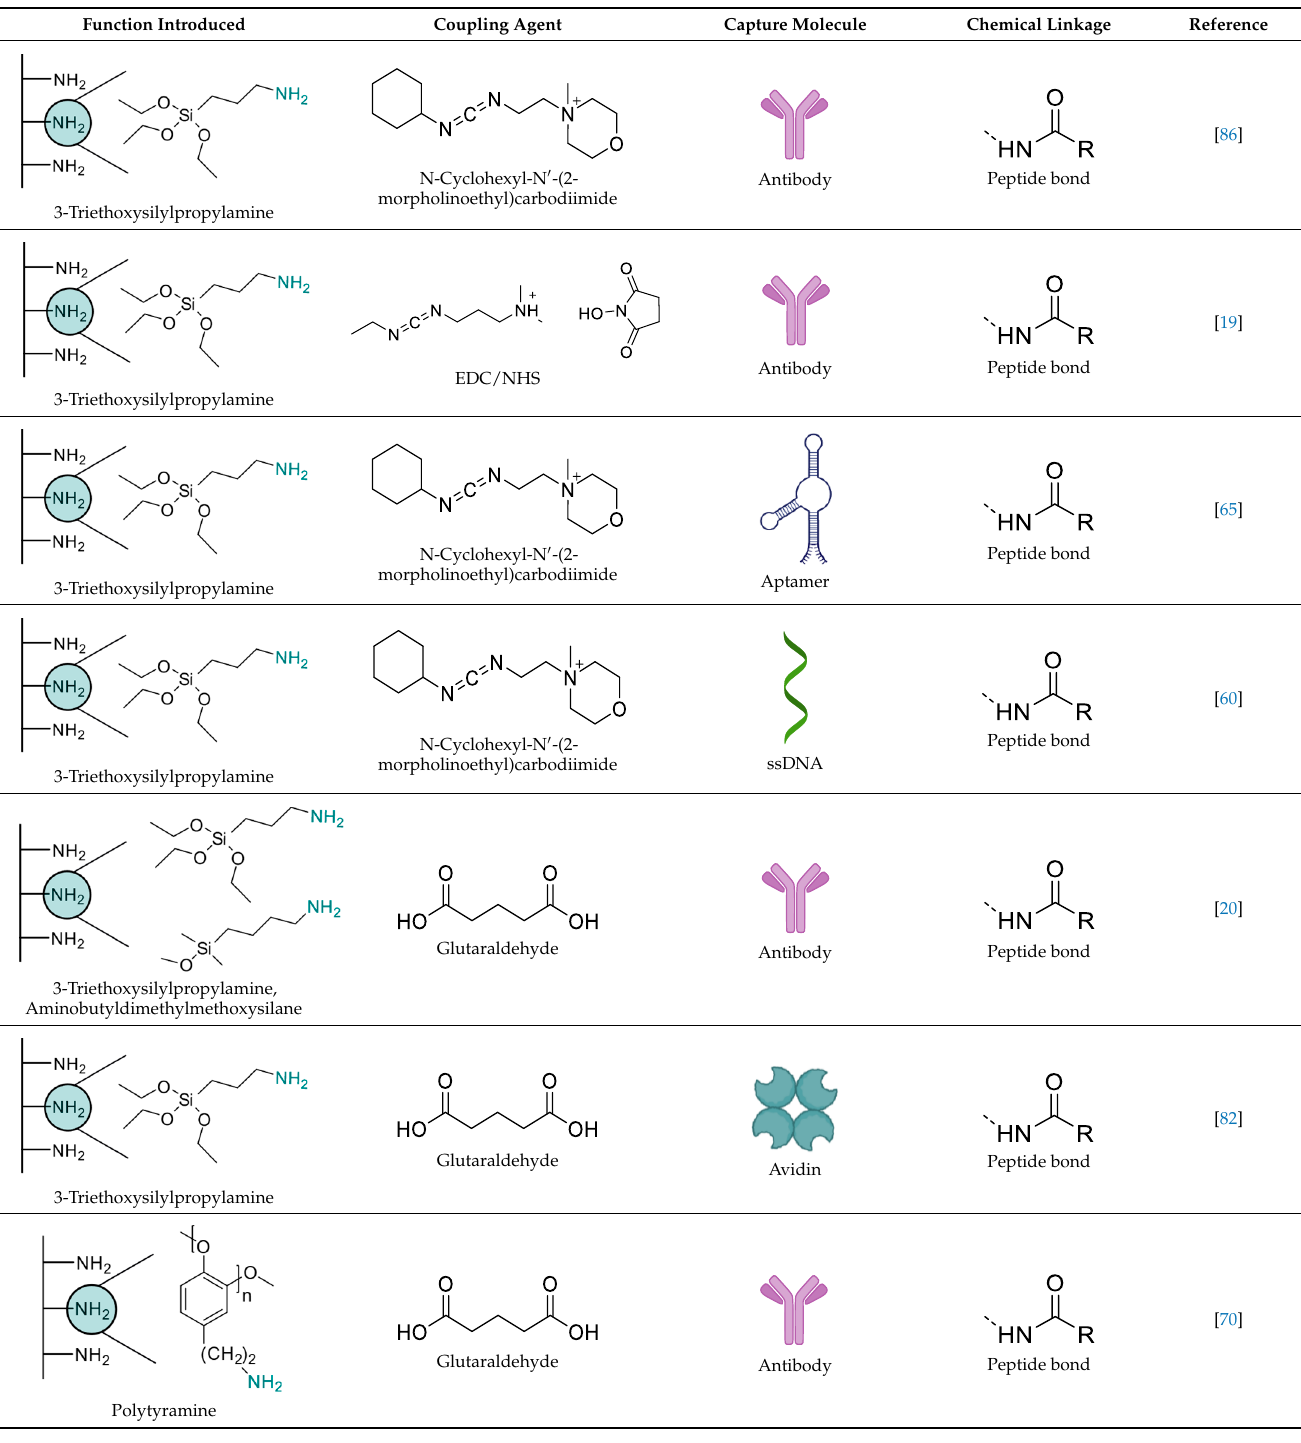
Table 2. Methods reported for the covalent conjugation of capture biomolecules on insulating layers. R: Capture molecule.